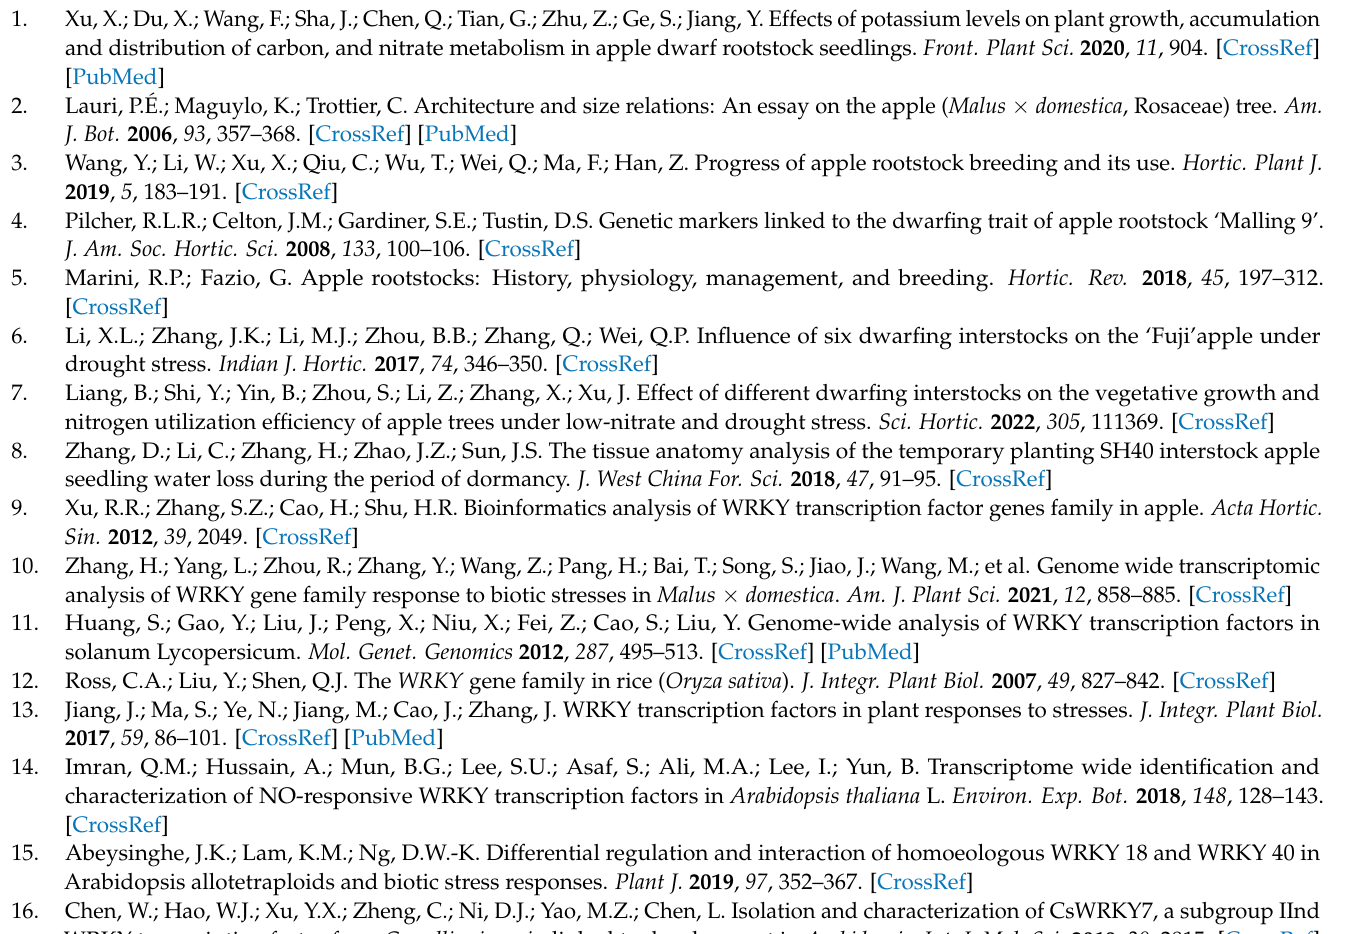
denote zinc finger motifs. Table S1: sequences of primers. Table S2: differentially expressed tran- scription factors between groups with M9 and Mr as interstocks. Table S3: differentially expressed transcription factors between groups with SH40 and Mr as interstocks. Table S4: differentially ex- pressed transcription factors between groups with SH40 and M9 as interstocks. Table S5: expression of WRKY TF family members in different stock and scion combinations. Table S6: WRKY transcription factors were not expressed in all three rootstock panicle